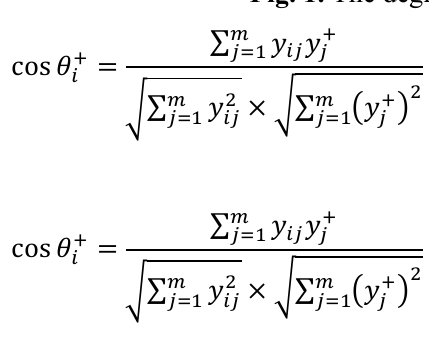
Fig. 1. The degree of conflict between alternatives and